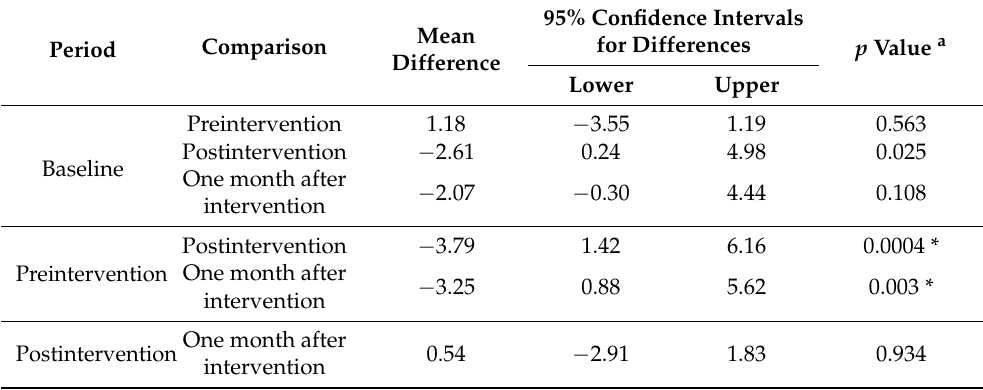
Table 3. Multiple comparisons of the students’ total DDS scores across the four time points ( n = 28).